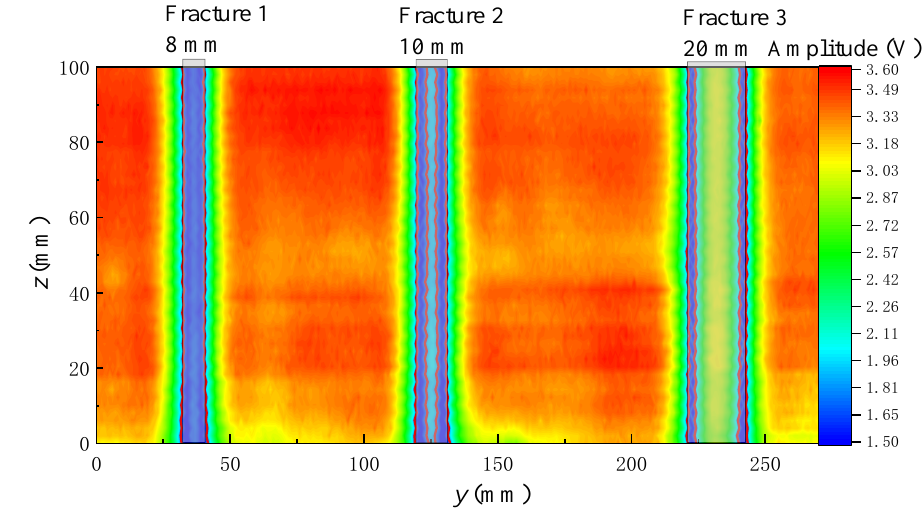
Figure 17. Echo amplitude imaging diagram for the grooved sandstone Plate 1.